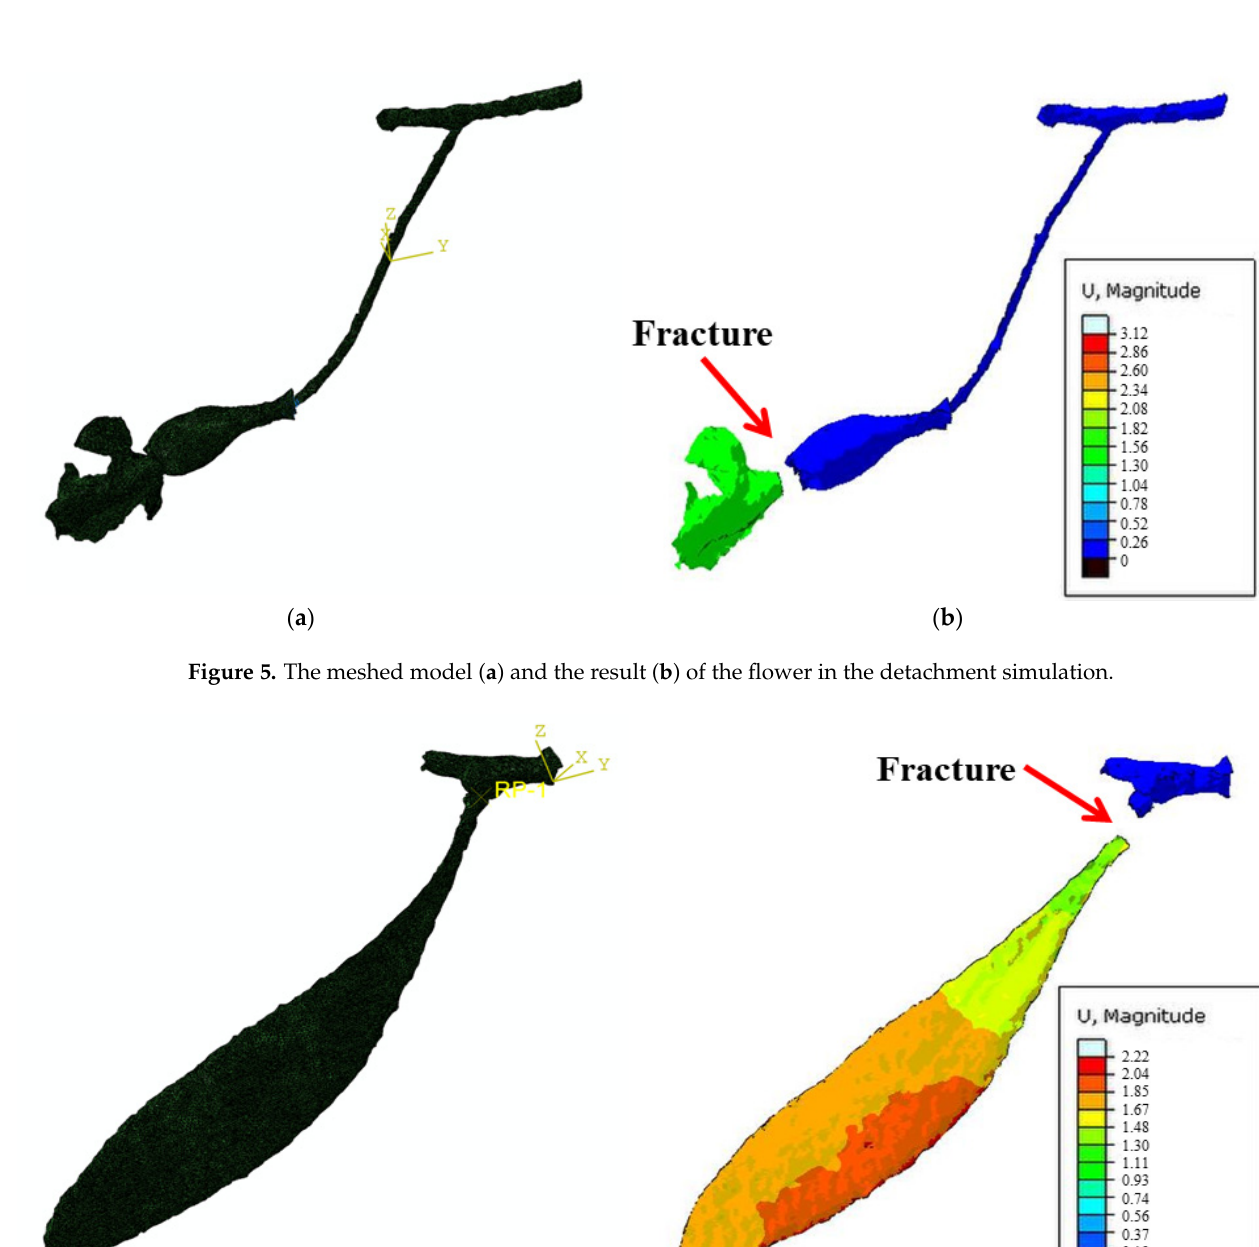
Figure 4. The meshed model ( a ) and the result ( b ) of the unripe fruit in the detachment simulation.